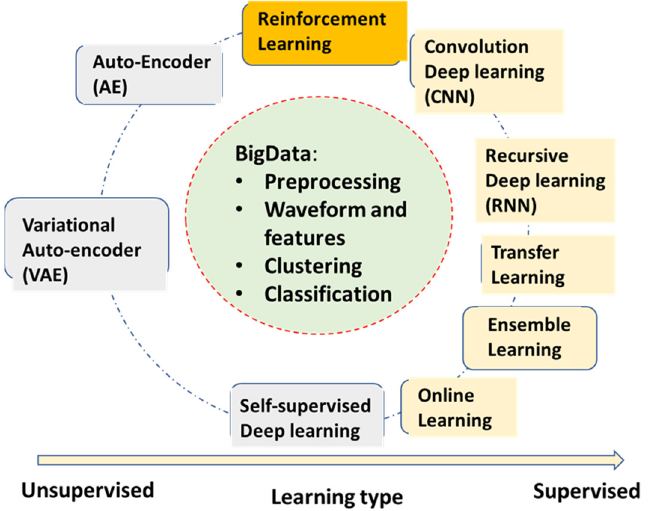
Figure 3. A diagram of a summary of DL algorithms. DL models rely on big data. For AECG, a large ECG waveform database with corresponding labels is needed for training purposes. In the list, CNN and RNN are the most popular DL models. Transfer learning and ensemble learning also become practical for AECG. However, there has been limited use of reinforcement learning and self- supervised learning thus far. AE and VAE are very useful for noise detection and feature